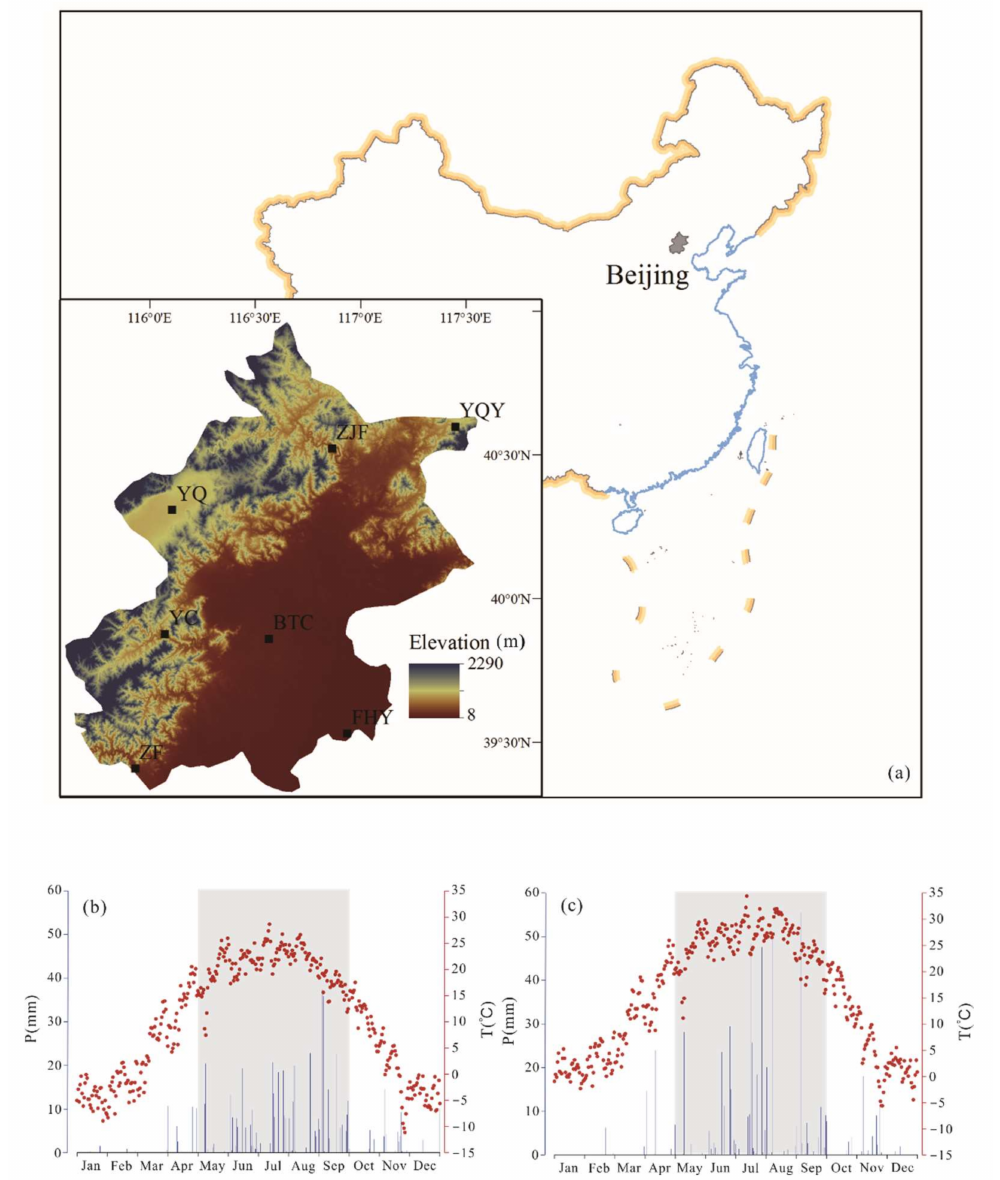
Figure 1. ( a ) Topography and locations of sampling stations for precipitation isotopes over the Beijing region (BNIP). Daily precipitation amount and temperature variations at ( b ) YQ and ( c ) BTC stations during 2015. Data at YQ station were obtained from the China Meteorological Data Sharing Service System (CMDSSS, http://cdc.cma.gov.cn/home.do (accessed on 1 January 2018). BTC station data were collected by the authors for this study. The shaded part in the figure indicates the monsoonal season from May to September. The red points and blue lines represent temperature and precipitation amounts,